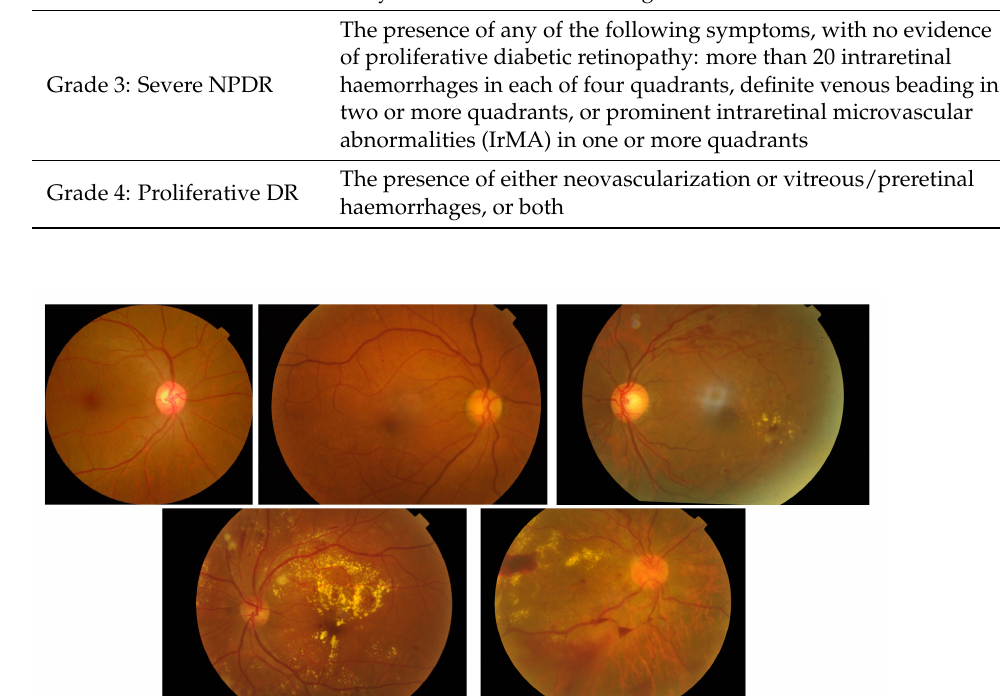
Figure 2. Series of DR images representing different grades are shown in order from top left to bottom right, ranging from grade 0 to grade